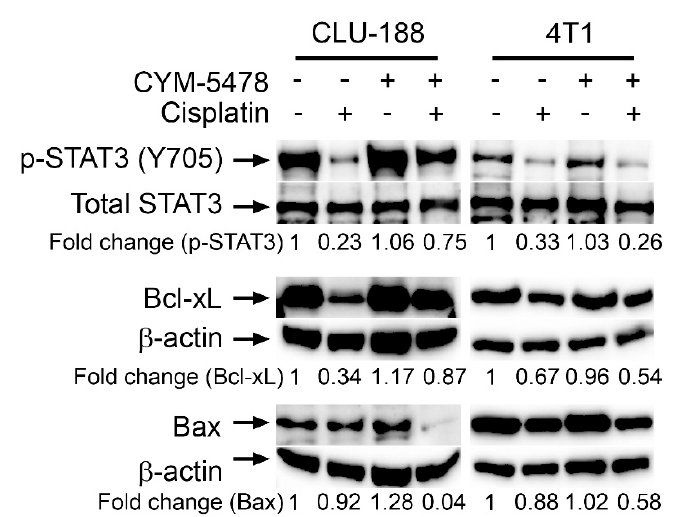
Figure 5. CYM-5478 promotes anti-apoptotic pathways in neural but not breast cancer cells. Cisplatin (20 µ M) and CYM5478 (20 µ M) either alone or in combination were treated for 24 h, after which western blot analysis was performed. CYM-5478 reverses cisplatin-induced suppression of anti-apoptotic phospho-STAT3 and Bcl-xL while inhibiting expression of pro-apoptotic Bax in CLU-188 mouse neural cells. CYM5478 had no e ff ect on cisplatin-induced suppression of phospho-STAT3 or Bcl-xL, and did not suppress Bax in 4T1 mouse breast cancer cells.